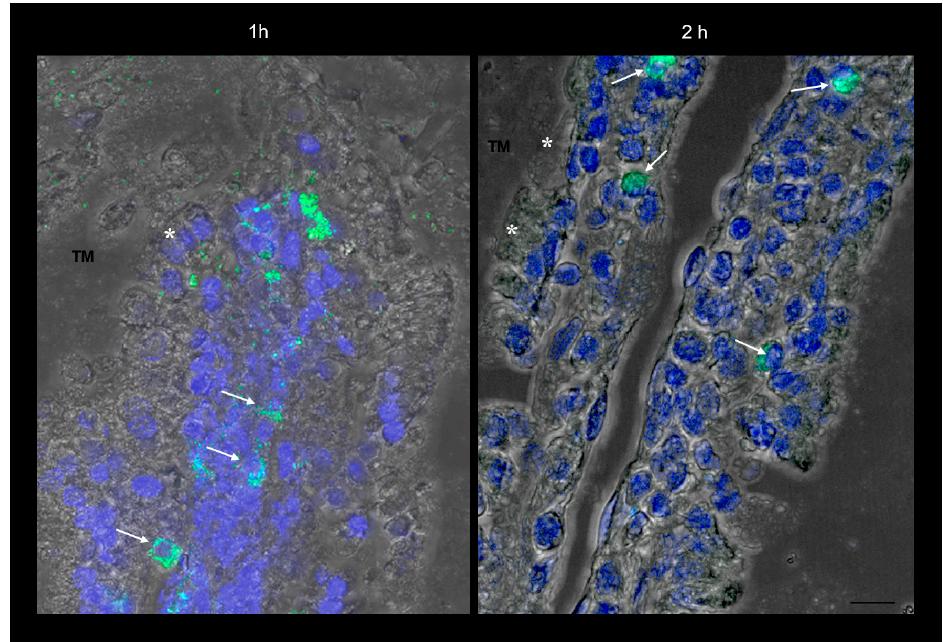
Figure 2. Confocal laser scanning microscopy: representative images of rat gut sections after 1 and 2 h incubation in an Ussing chamber. Asterisks indicate enterocytes; arrows indicate connective cells. TM: tunica mucosa. Individual fluorescent channels: green (SRM) and blue (nuclei). Scale bar 10 µm.